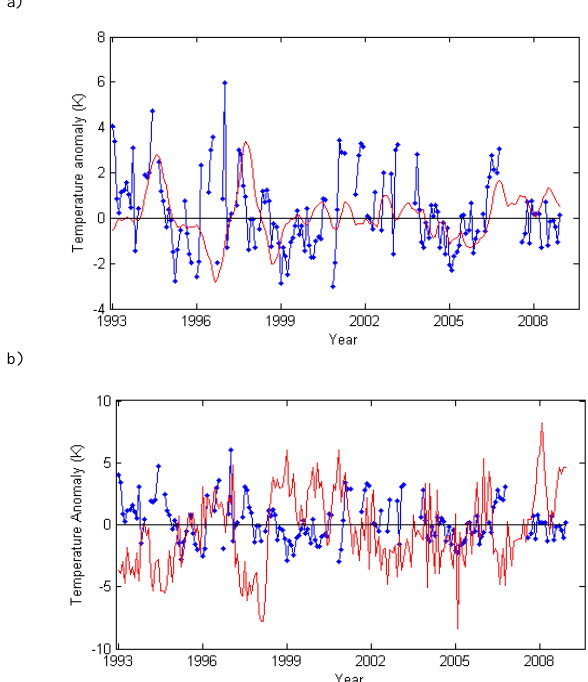
Figure 4: Time evolution of deseasonalised monthly averaged temperature at CPT (blue line) over Reunion derived from continuous observations during the period from January 1993 to December, together with (a) Indian Ocean Dipole (IOD) component as parameterized in the regression analysis (red line) and with (b) ENSO component as parameterized in regression analysis (red line).